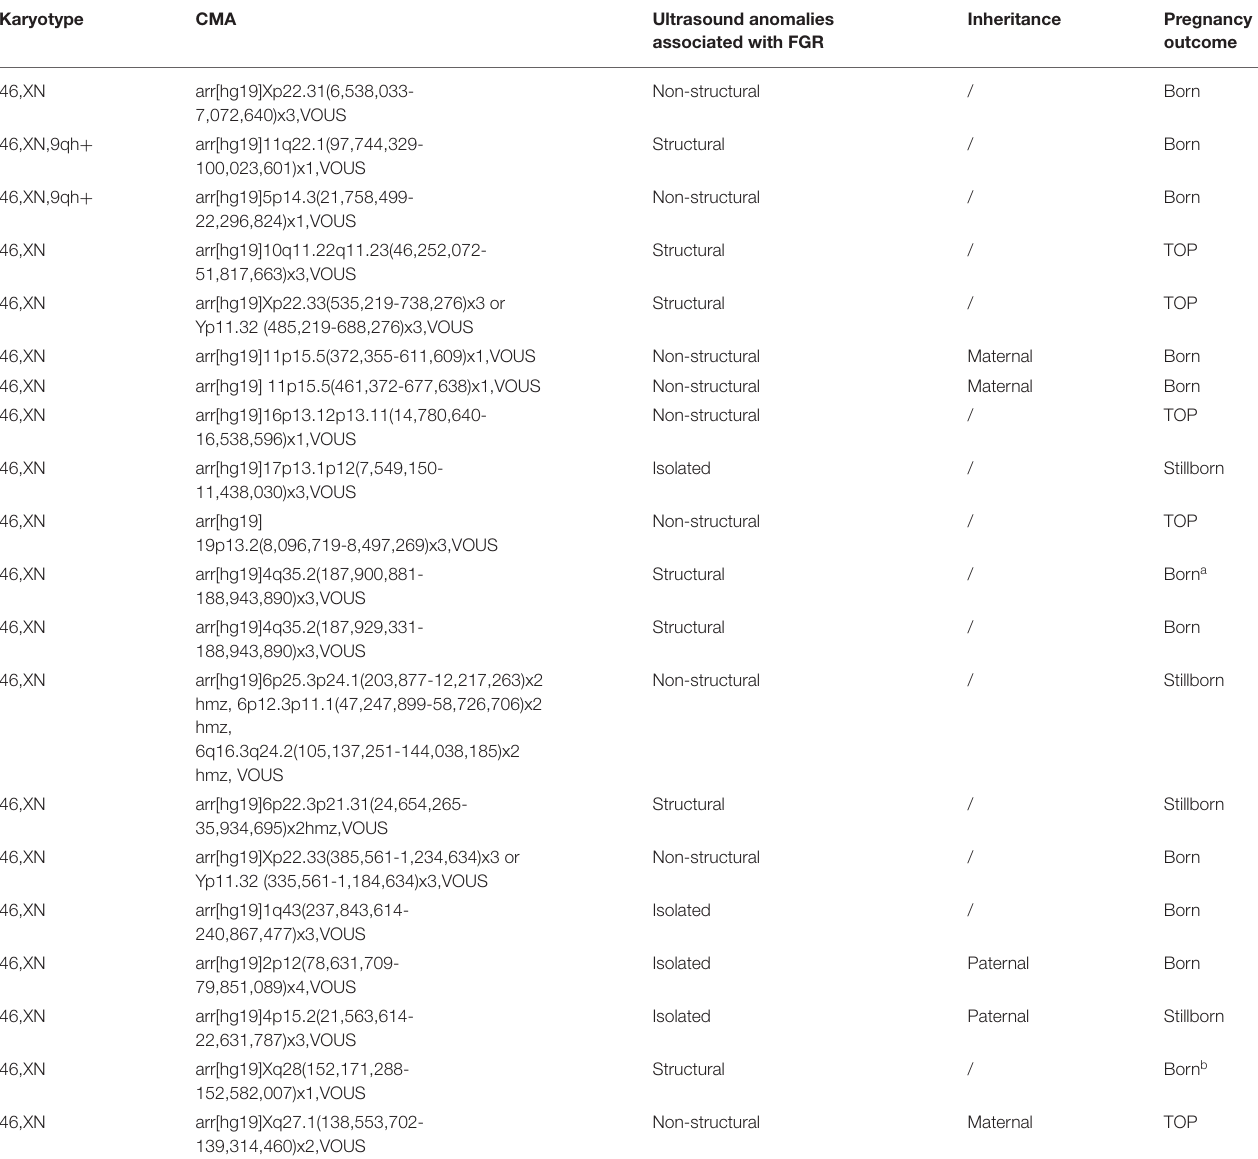
TABLE 2 | The variants of unknown significance detected by